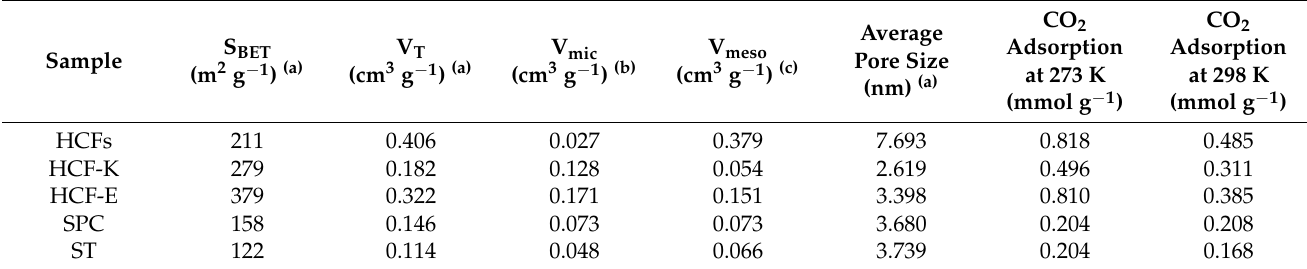
Table 1. Physical characteristics of the carbon